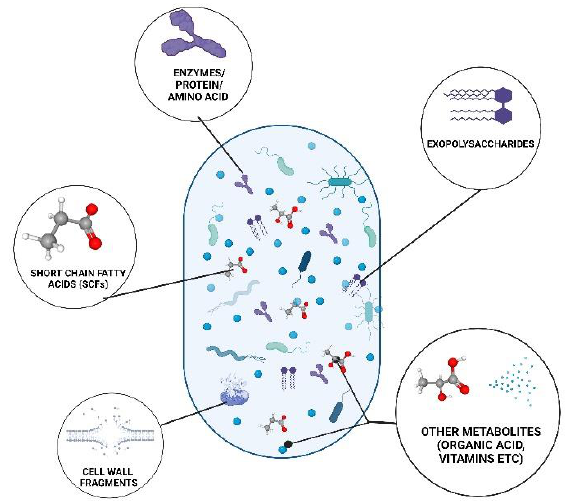
Figure 1. Schematic representation of postbiotic classification.